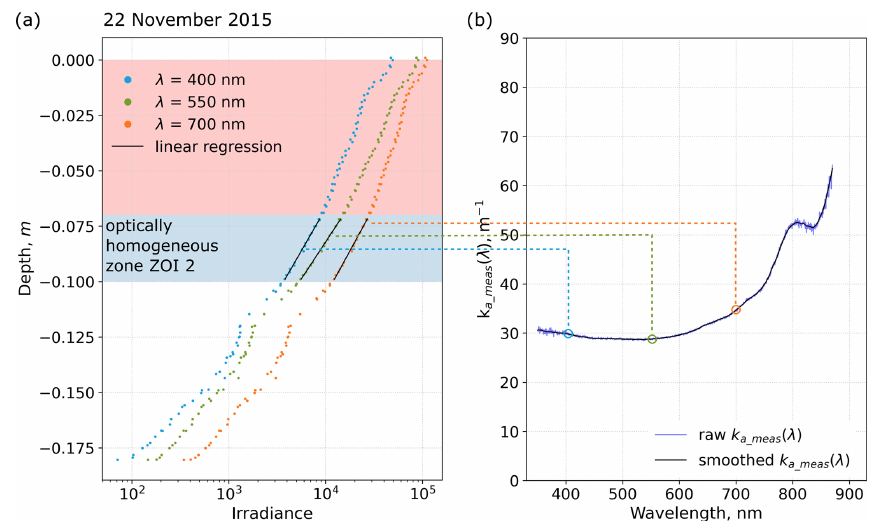
Figure 3. Overview of how the extinction coefficient ( k e_meas (λ) ) was determined from optically homogeneous layers in irradiance profiles. (a) Irradiance as a function of depth for selected wavelengths. The blue shaded area highlights an optically homogeneous zone where the recorded signal is linear on a logarithmic scale. The red shaded area was discarded due to potential influence of direct light. k e_meas (λ) is the slope of the linear regression of irradiance vs. depth in the optically homogeneous zone (black lines). (b) k e_meas (λ) determined for each wavelength in the measured spectrum (350–900nm) before (blue curve) and after smoothing (black curve). The figure layout was adopted from Tuzet et al. (2019) and modified using data measured near Umiujaq on 22 November 2015. The blue shaded area is subsequently referred to as